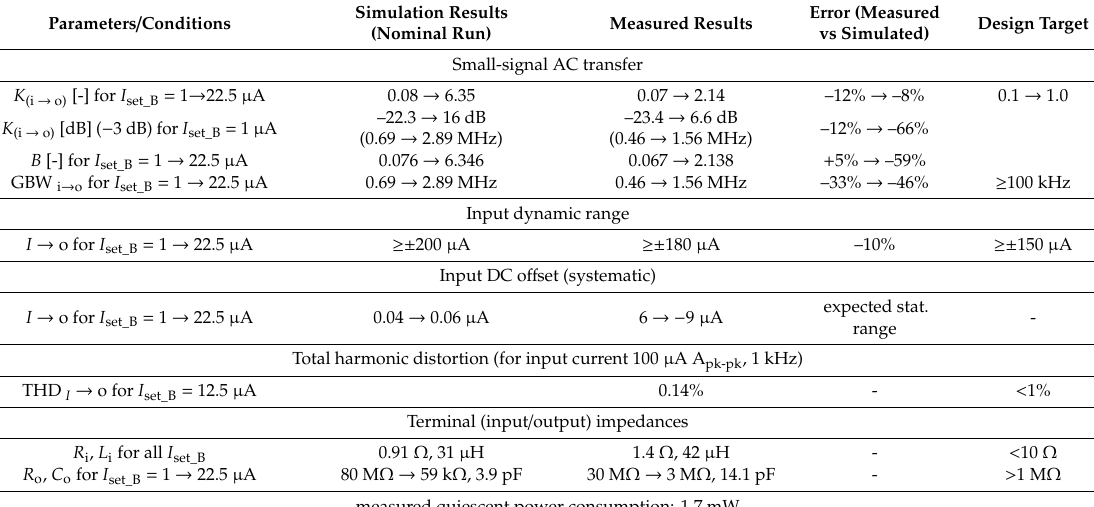
Figure A5. Full CMOS topology of the adjustable current amplifier (CA). Table A5. Summary of simulated and measured performances of the CA cell.